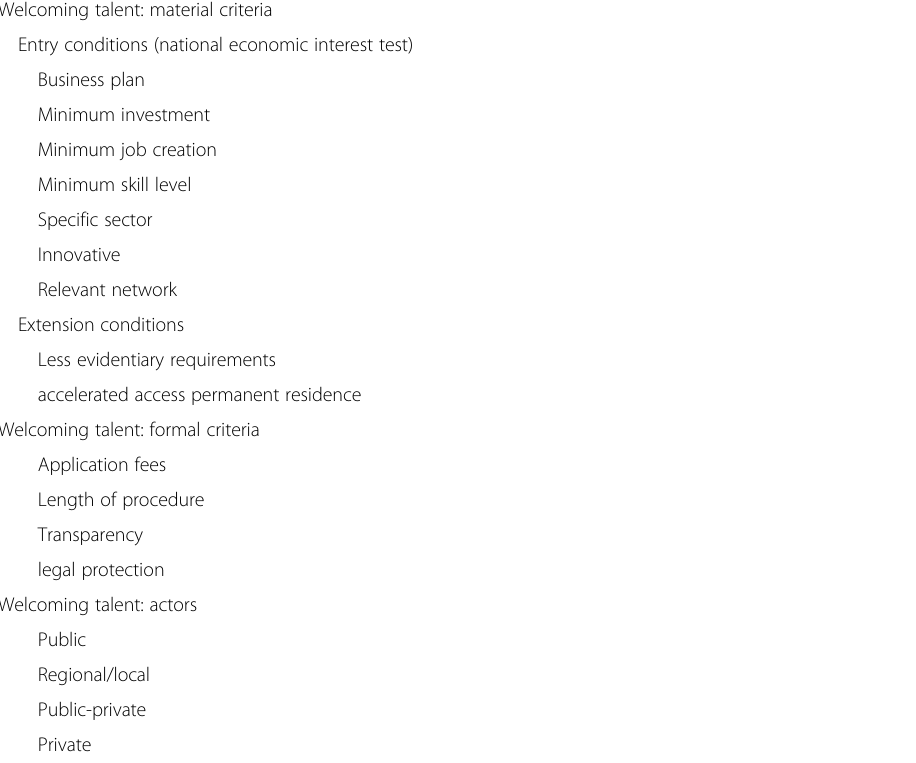
Table 1 Key criteria of the welcoming talent model Welcoming talent: material